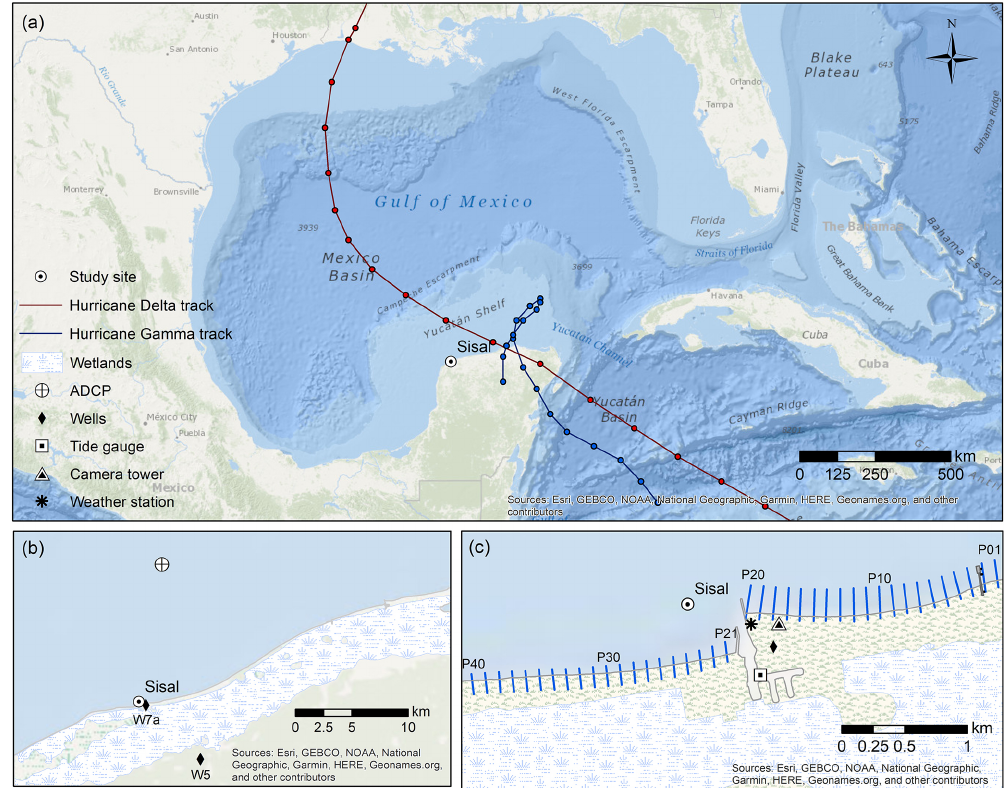
Figure 1. Study area showing (a) best track positions for Hurricane Gamma and Hurricane Delta (National Hurricane Center, https://www. nhc.noaa.gov/data/tcr/index.php?season=2020&basin=atl, last access: December 2022), (b) the location of the acoustic Doppler current profiler (ADCP) and the monitoring wells, and (c) coastal monitoring systems and beach transects.